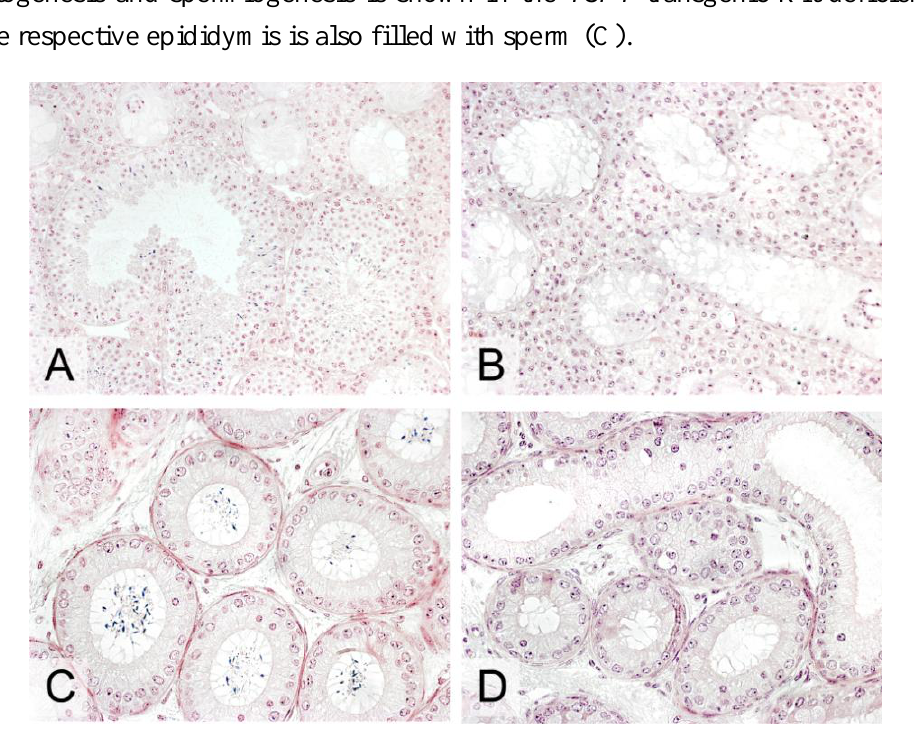
Figure 4. Histological haematoxylin and eosin stained sections of testes ( A , B , orginal magnification x200) and epididymides ( C , D , orginal magnification x400) of adult B6;NMRI -Kit W-v /Kit W-v Tg(TSPY) (A,C) and B6;NMRI -Kit W-v /Kit W-v male mice (B,D). While